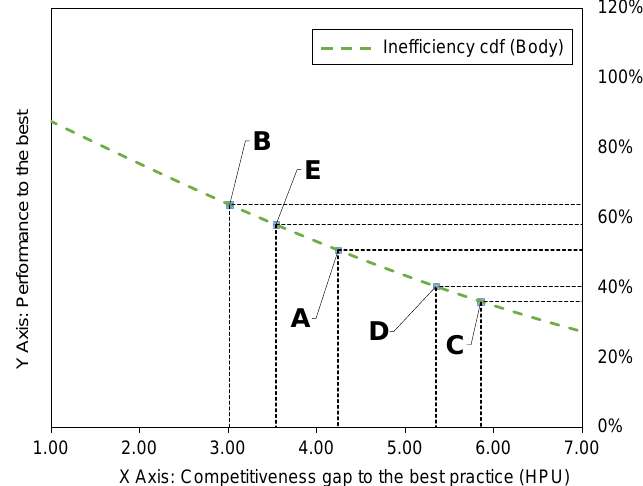
Figure 3. Assessment for Bodyshop.